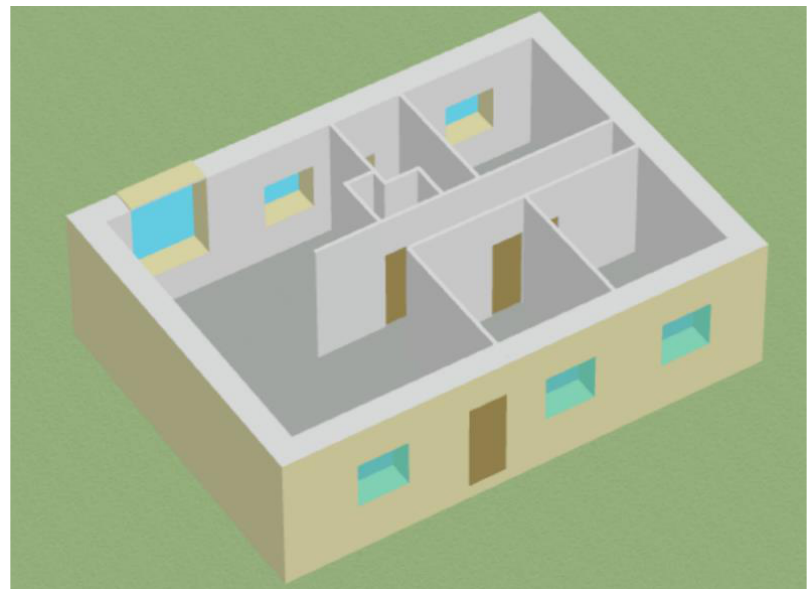
Figure 11. Three-dimensional plan of the studied housing. Table 10. Thermal properties of the materials constituting the building